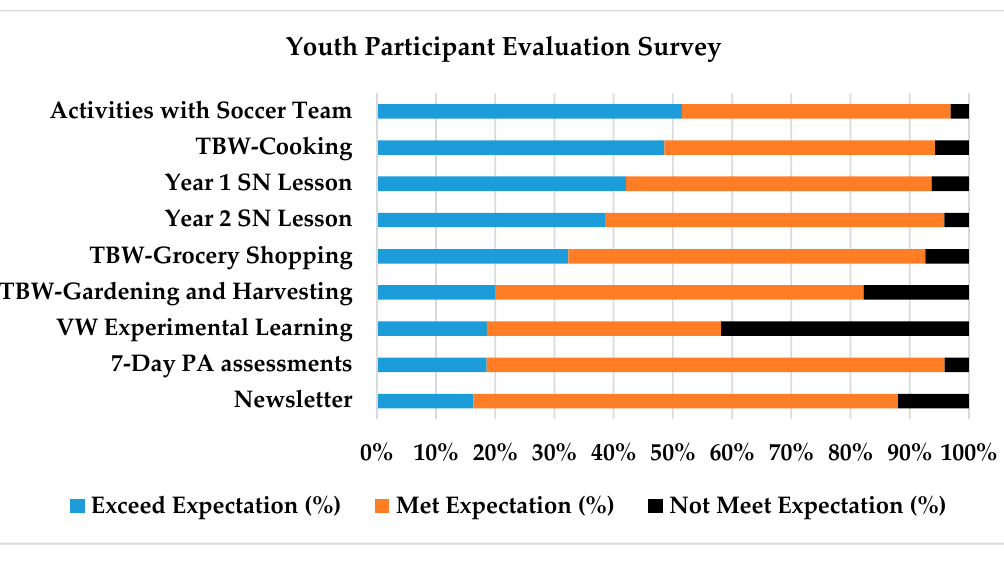
Figure 2. Youth rating on intervention activities. TBW: team-building workshop; SN: sports nutrition; VW: virtual world; PA: physical activity.